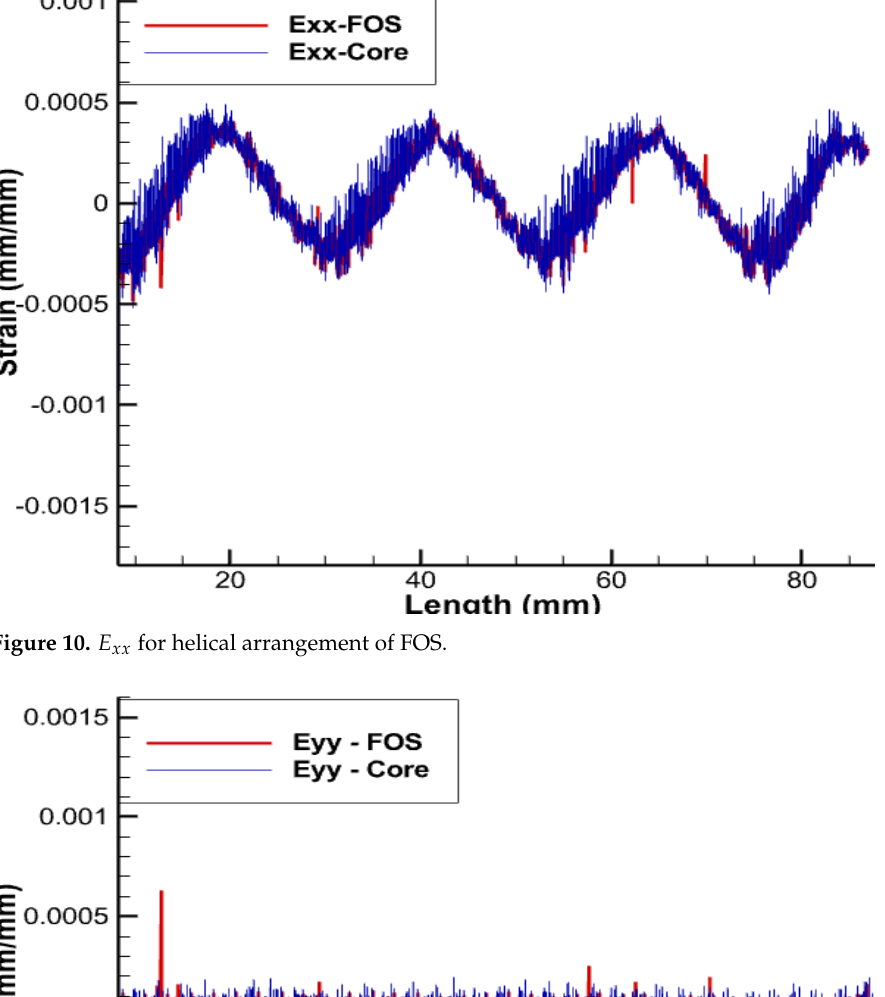
Figure 10. E xx for helical arrangement of FOS.